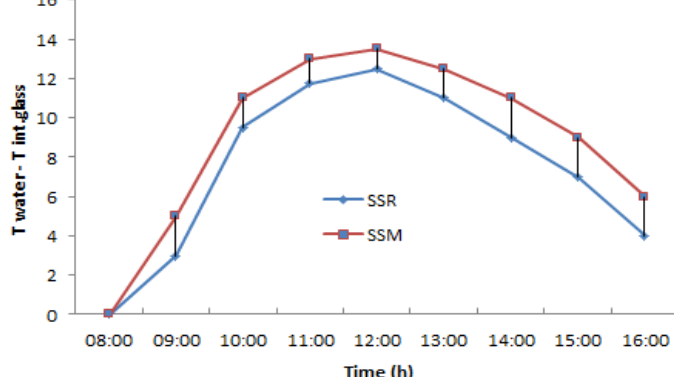
Figure 5. Temperature difference between the water and the glass cover (inner side)